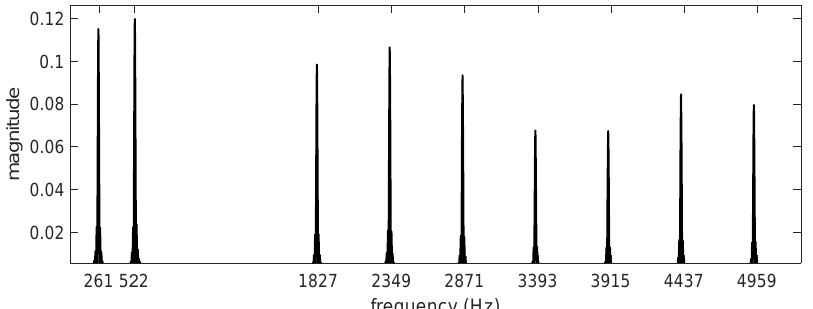
Figure 1. Frequency spectrum of the TL stimulus sound, s c ( t ; α 30 , φ 30 ) , showing the relative magnitudes (spectral amplitudes in arbitrary units) of the pure tones used in the